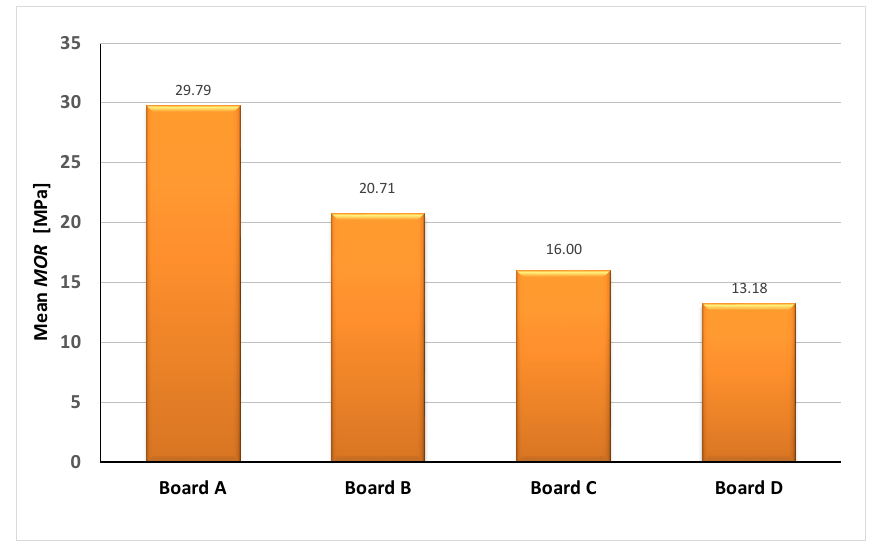
Figure 2. Mass moisture content in tested boards.